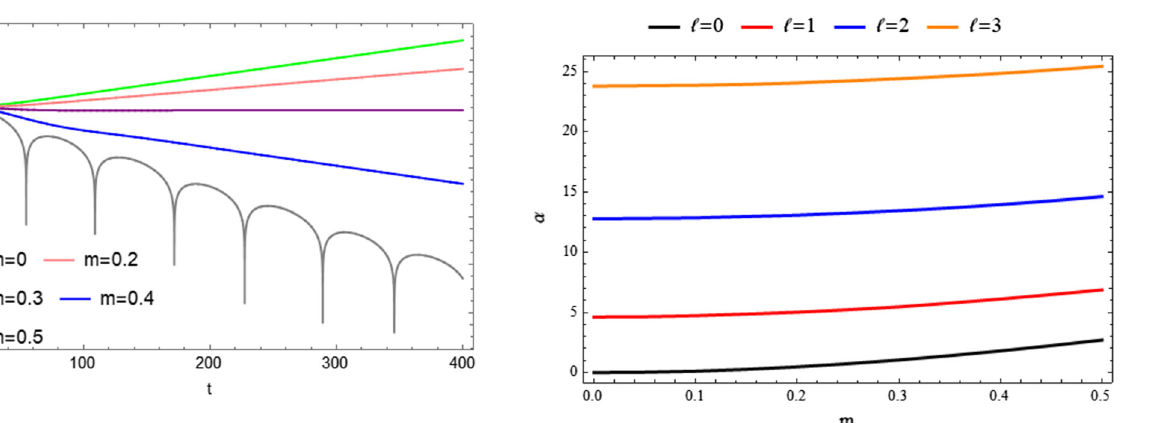
Fig. 9 The time evolution of the (cid:4) = 1 mode with fixed α = 5 . 49 The regularity near the black hole horizons give us